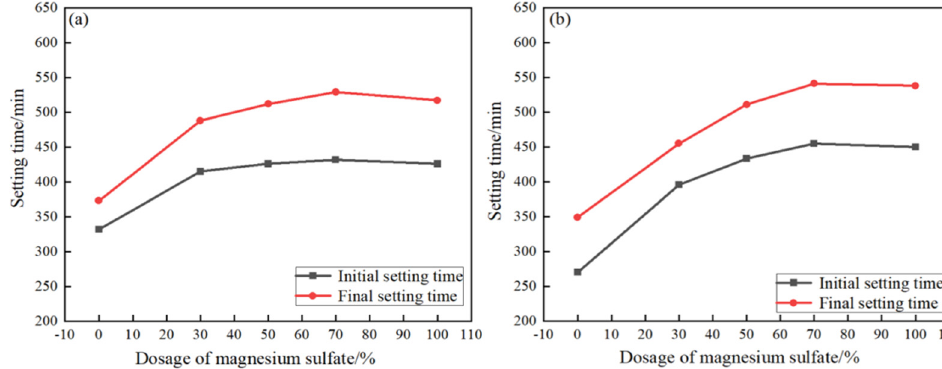
Figure 1. The setting time of MOC at different mass fractions of MgSO4 ( a ): 6:1:15; ( b ):